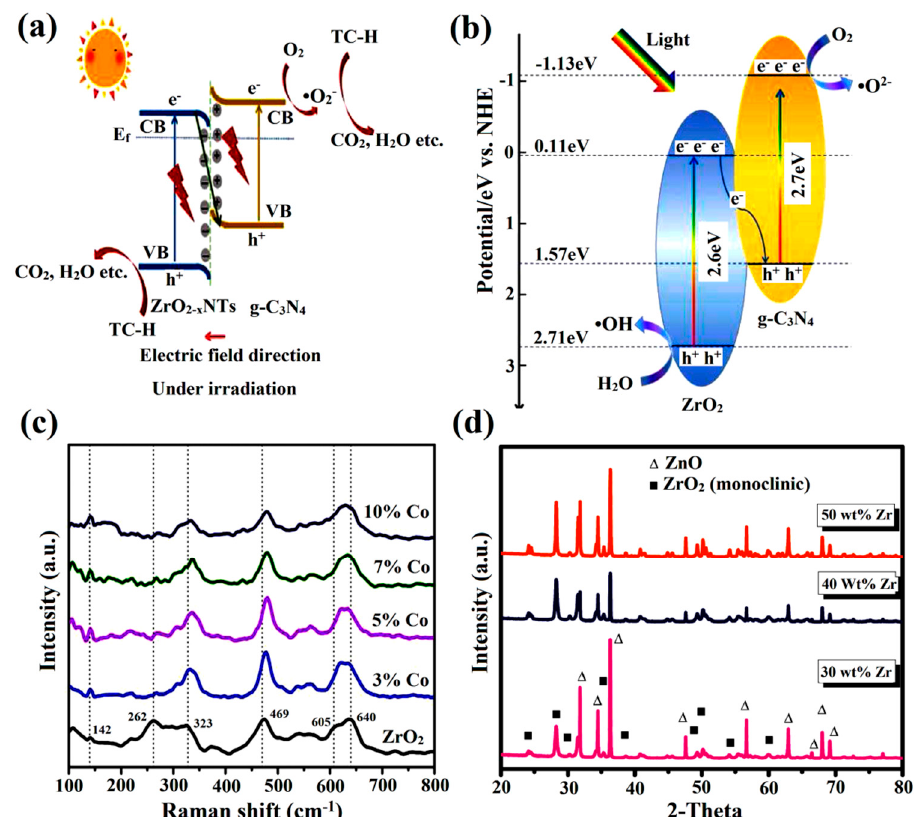
Figure 4. ( a ) Systematic representation of TC-H degradation in g-C 3 N 4 /ZrO 2 − x NTs, reprinted with permission from Elsevier (License NO. 5332980412880) [55]. ( b ) The plausible photocatalytic mechanism of g-C 3 N 4 /ZrO 2 heterostructure, reproduced with permission from Elsevier (License NO. 5332980598897) [26]. ( c ) Raman spectra of pure ZrO 2 and Co doped ZrO 2 NPs, reprinted with permission from Elsevier (License NO. 5332971176132) [25]. ( d ) XRD analysis of pure ZnO and Zr-doped ZnO, reprinted with permission from Elsevier (License NO. 5332980782041)